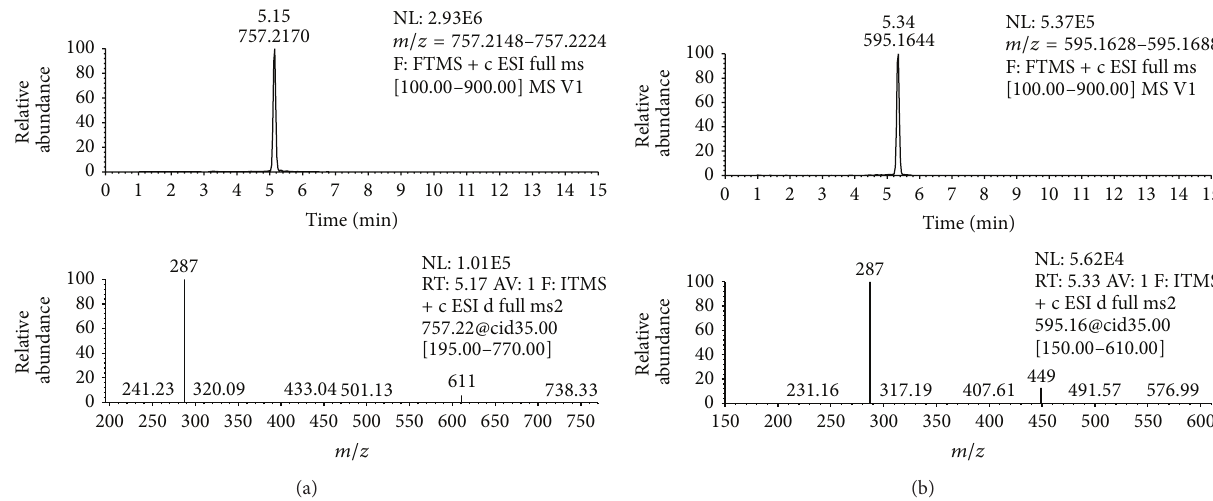
Figure 3: Extracted ion chromatograms and MS/MS spectra of (a) cyanidin-3-glucosylrutinoside and (b) cyanidin-3-rutinoside.